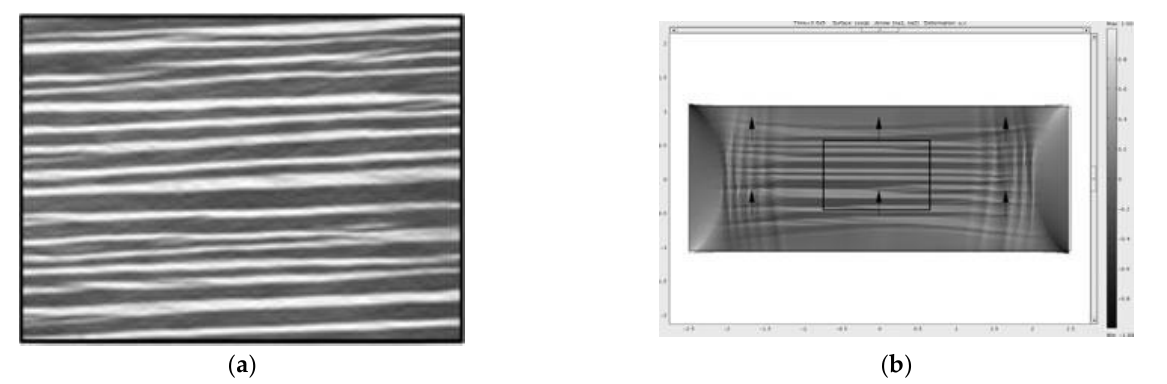
Figure 3. ( a , b ) Compare experimental data numerical results, obtained from a stretching experiment, are shown in ( a , b ), respectively [39]. The stretching direction was horizontal (Reprinted with permission from [39]).